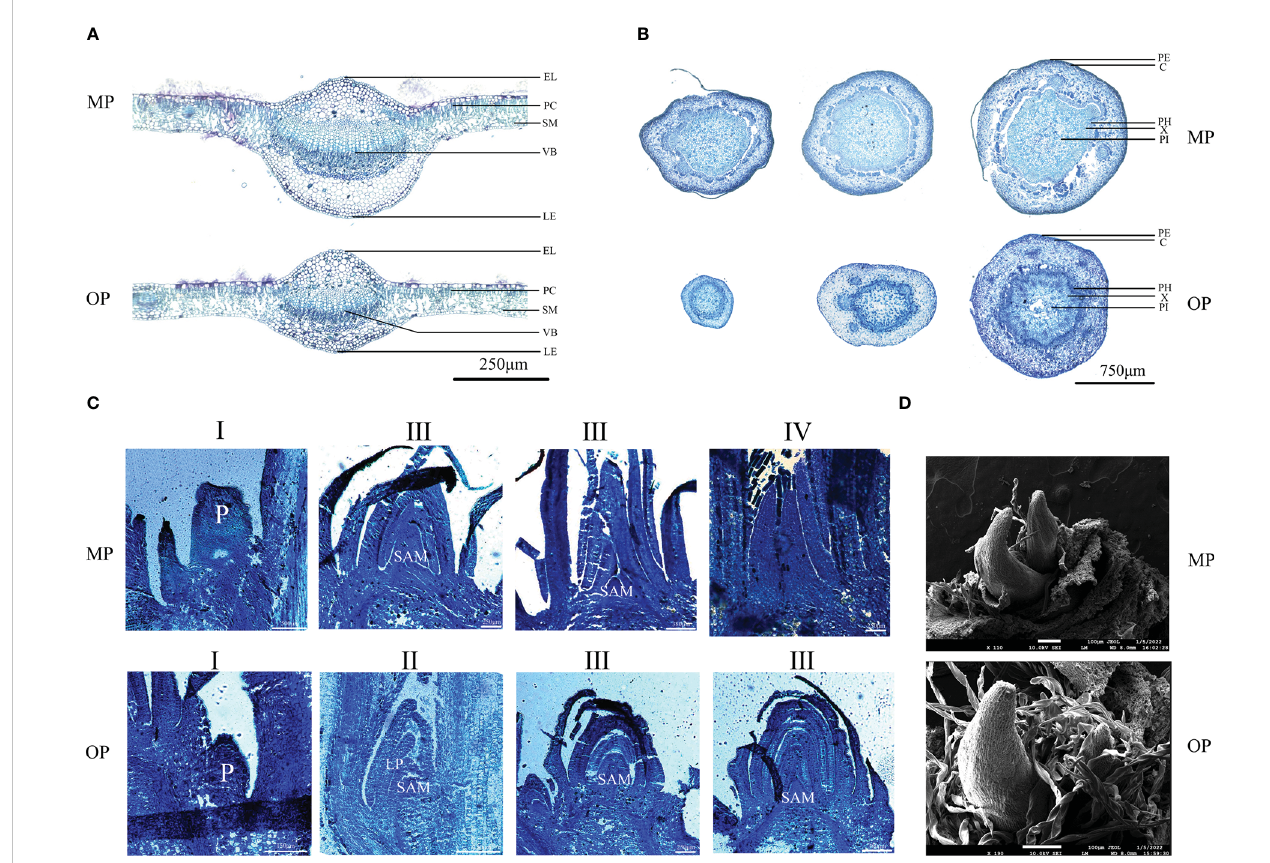
FIGURE 2 Anatomy of the vegetative organs of the wild type (OP) and mutant (MP). (A) Transverse sections of the leaf. EL, epithelial layer; PC, palisade mesophyll; SM, spongy mesophyll; VB, vascular bundle; LE, abaxial epidermis. (B) Transverse sections of the stem of the new shoots. Sections from leaf to right are from the shoot tip, mid-stem, and the shoot base, respectively. PE, periderm; C, cortex; PH, phloem; X, xylem; PI, pith. (C) Longitudinal sections of bud primordia at different stages of development, namely initiation preparation stage (I), initiation stage (II), formation stage (III), and maturation stage (IV). SAM, shoot apical meristem; LP, leaf primordium; P, bud primordium. (D) Scanning electron micrographs of dormant axillary